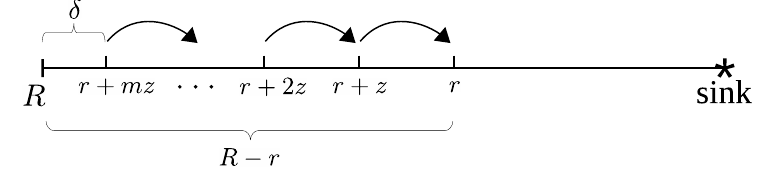
Figure 9. Derivation of Equation